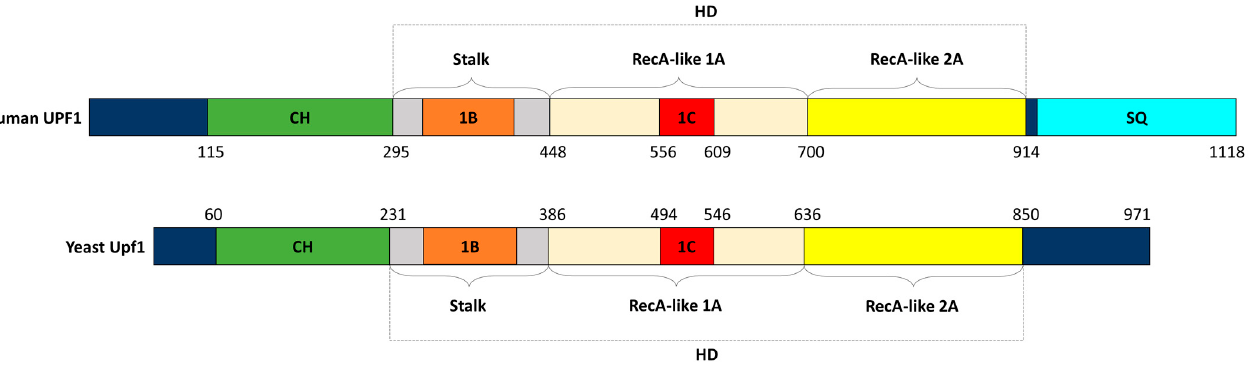
Figure 1. Domain structure of human UPF1 and yeast Upf1 proteins. Cysteine–histidine-rich domain (CH) marked as a green box. Helicase domain (HD) bound with a dashed line box containing stalk region as gray, RecA-like 1A as wheat, RecA-like 2A as yellow and 1B and 1C subdomains as orange and red boxes, respectively. Region rich in serine/glutamine/proline repeats (SQs) marked as cyan box.